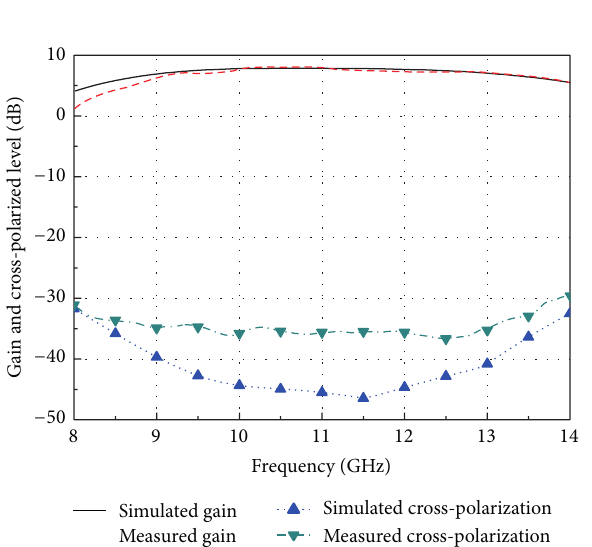
Figure 14: Far-field pattern at 10GHz.